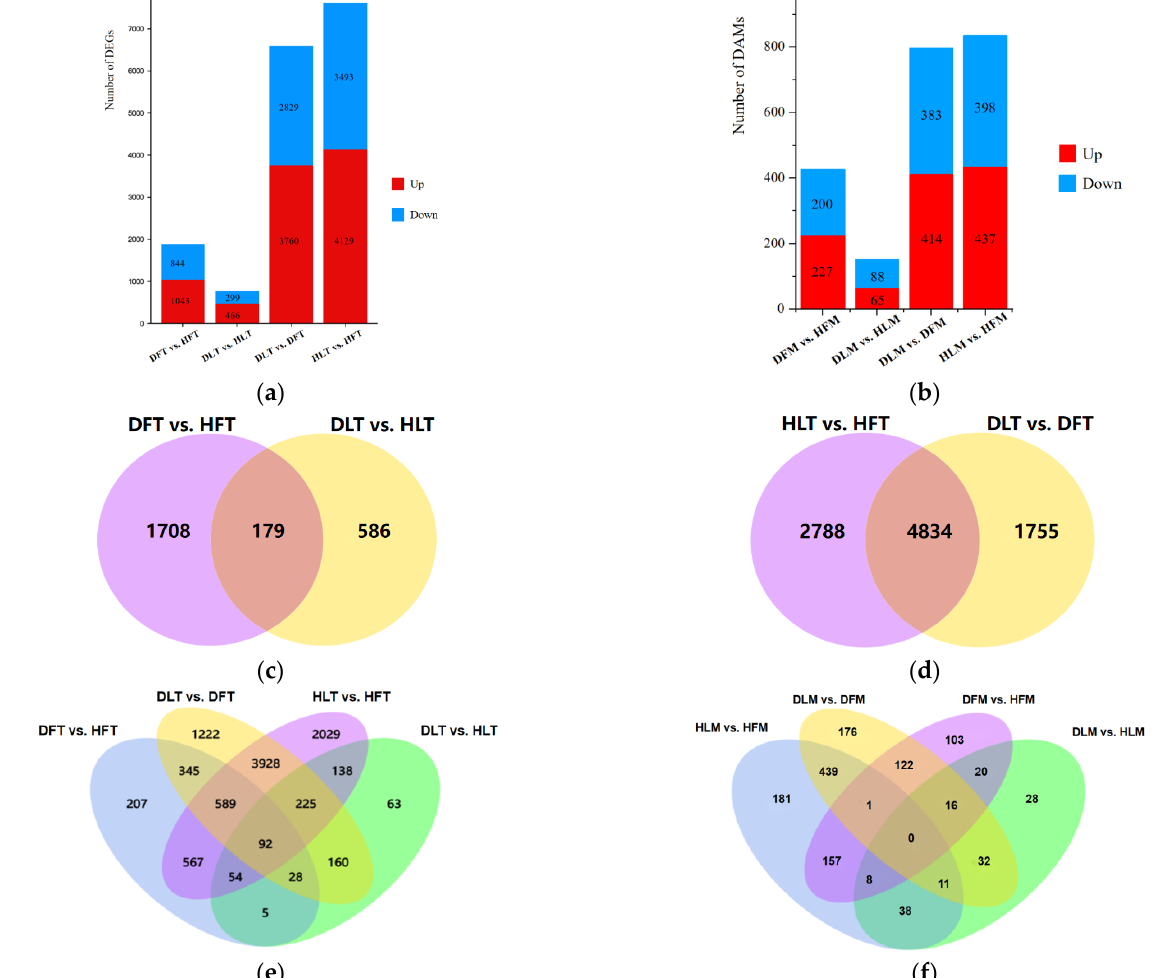
Figure 3 . The histogram and Venn diagrams of differentially expressed genes (DEGs) and differ- entially accumulated metabolites (DAMs) in huanglongbing (HLB)-affected and healthy leaf and fruit pith samples. ( a ) The histogram of the number of DEGs. ( b ) The histogram of the number of DAMs. ( c – e ) The Venn maps of DEGs in different combinations. ( f ) The Venn diagrams of DAMs of CLas-infected and healthy tissues. DF, diseased fruit pith. DL, diseased leaf. HF, healthy fruit pith. HL, healthy leaf. T, transcriptome analysis. M, metabolome analysis. Different colors indicate different comparison combinations.